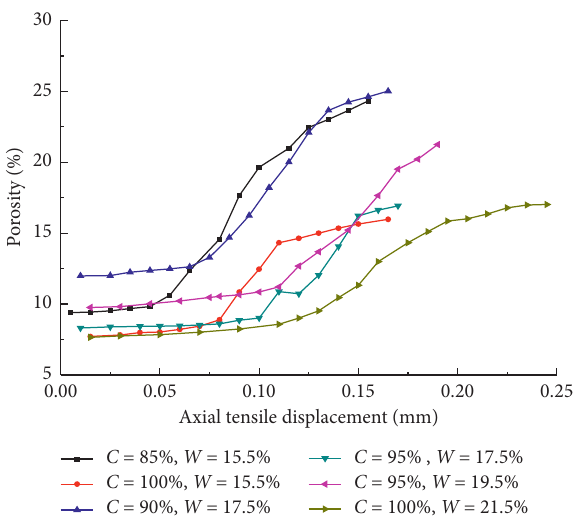
Figure 18: The change of porosity in Zone 1.